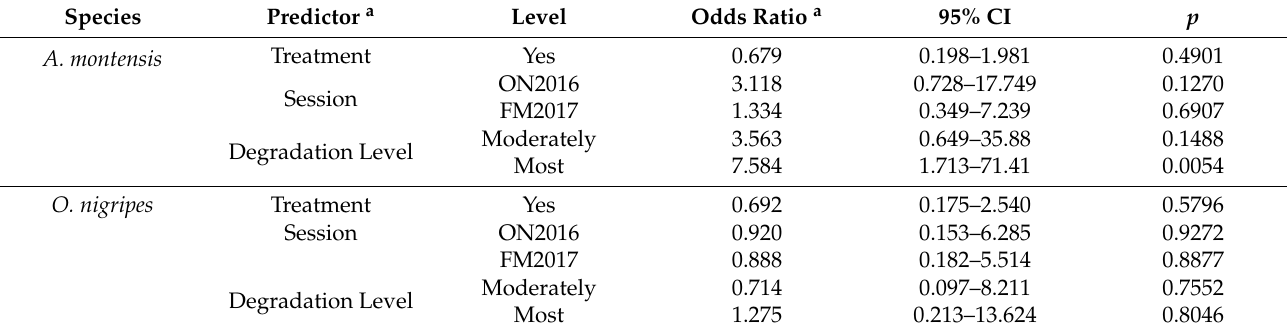
a For each predictor, the reference group for each level are the levels not shown. The odds ratio for “Treatment” is in reference to the control (unenclosed) grids. The odds ratio for “Session” is in reference to the “PreTrt” session. The odds ratio for “Degradation level” effect is in reference to the least degraded